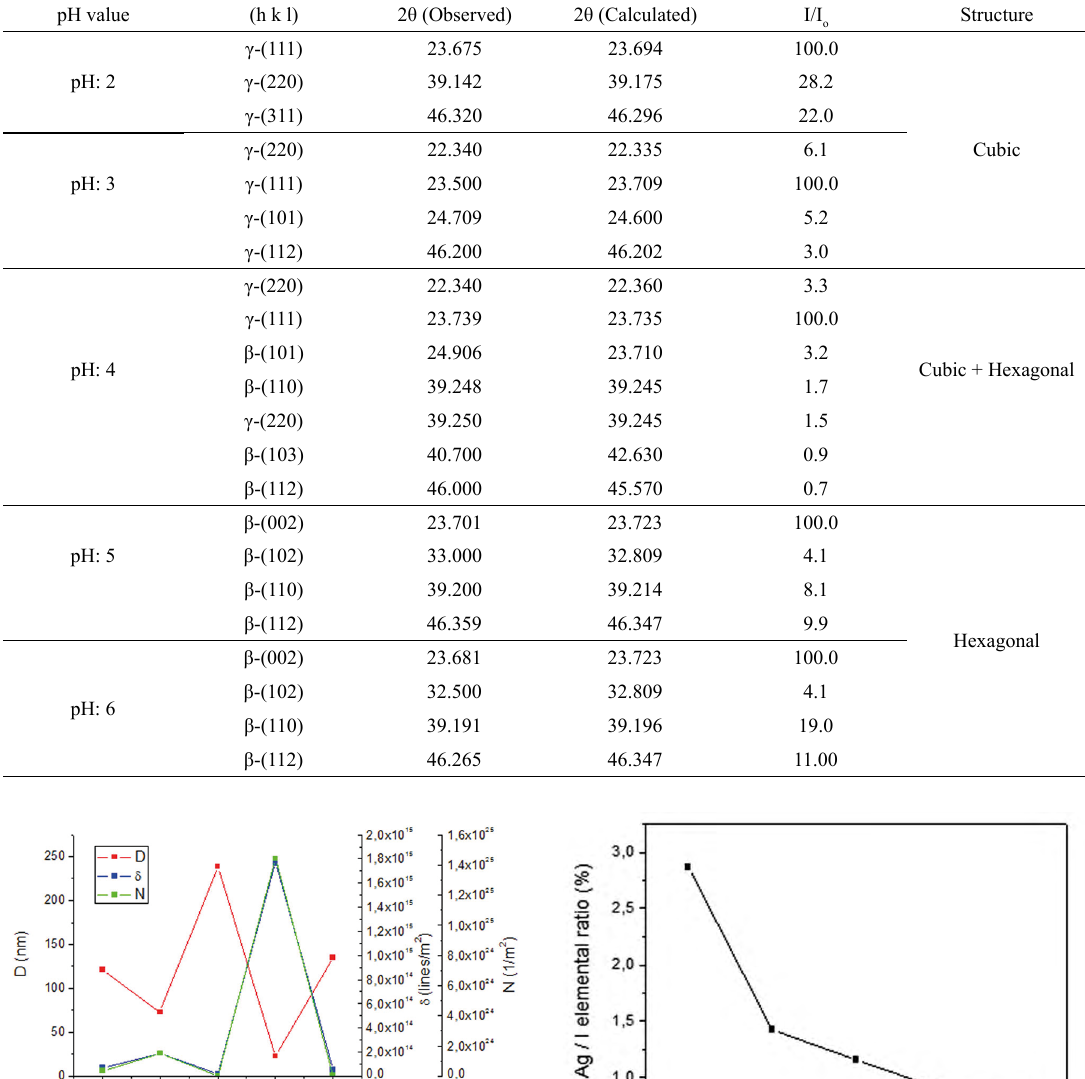
Table 1. The observed and literature peaks (ASTM Data) and crystal orientations at the diffraction angle for the crystals grown at different pH